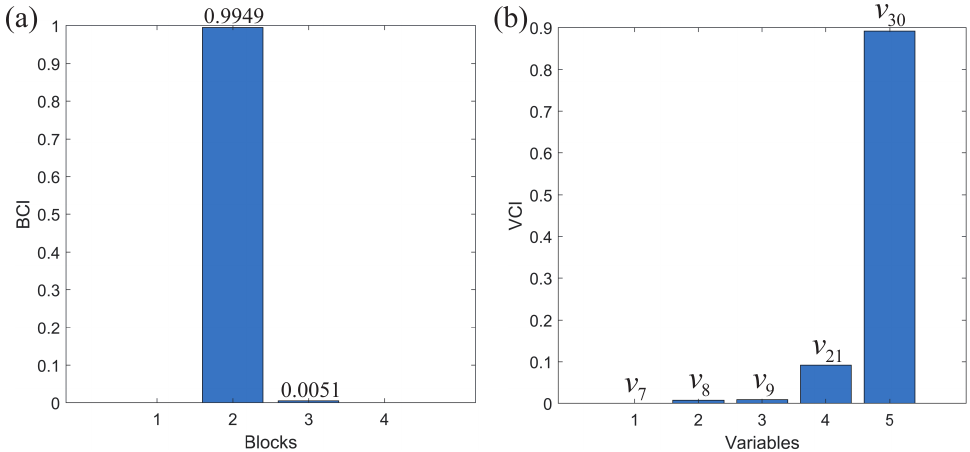
Figure 11. The anomaly isolation results in TE process with IDV (14). ( a ) BCI; ( b ) VCI-Block 2.